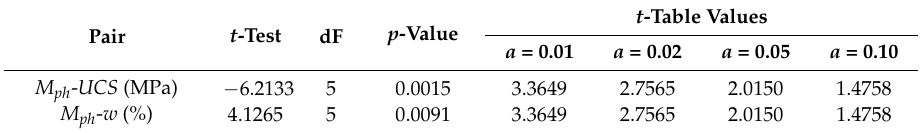
Pair t -Test dF p -Value